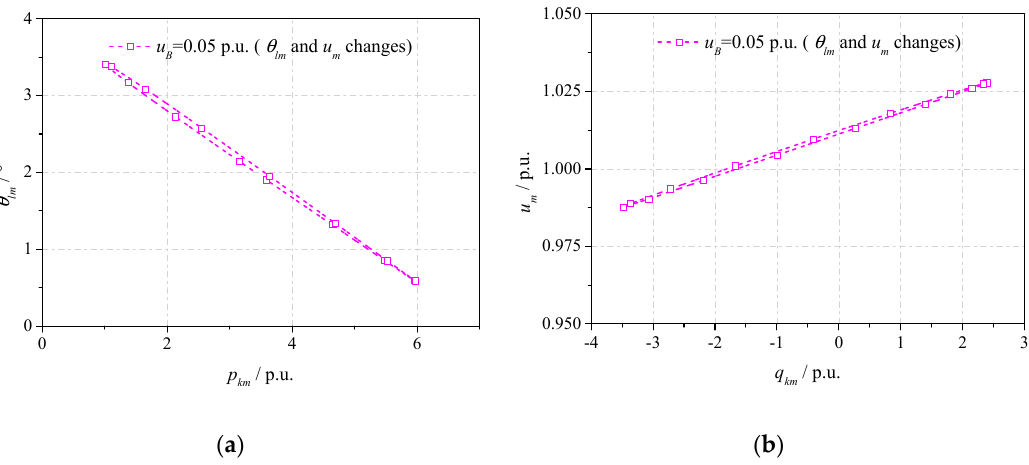
Figure 5. Calculation results considering the changes of θ lm and u m . ( a ) p km - θ lm curve; ( b ) q km - u m curve.